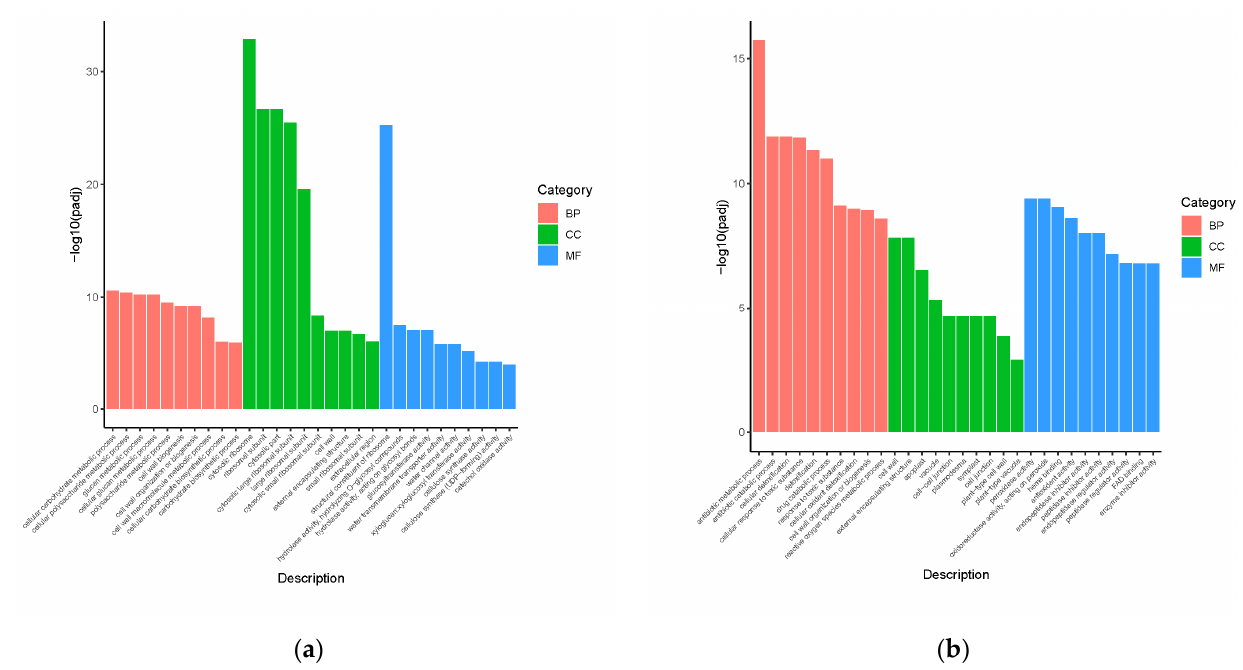
Figure 3. GO classification of differentially expressed genes (DEGs) in the shoots ( a ) and roots ( b ) of poplars fertilized with Gln.